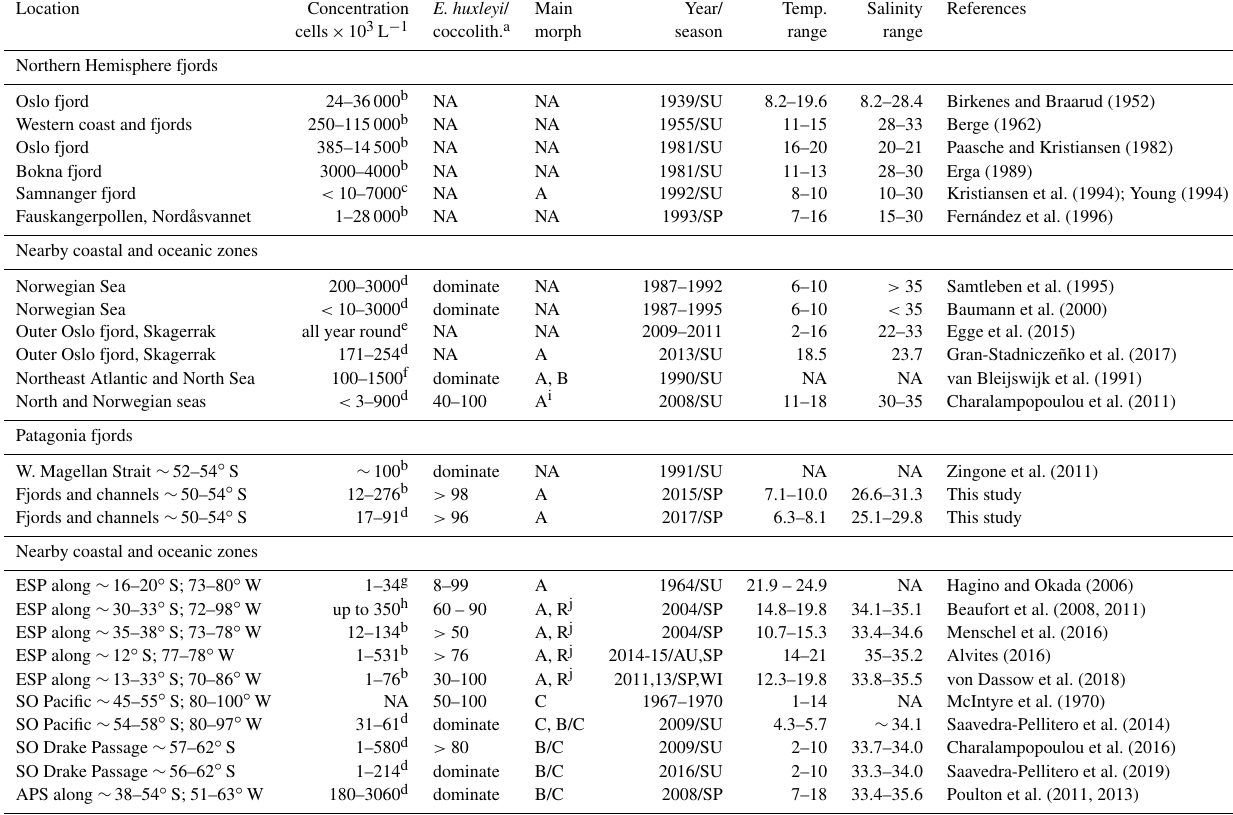
Table 4. Comparison of E. huxleyi standing stocks and morphotypes recorded in northern and Patagonia fjord systems and nearby coastal/ocean locations. Temperature and salinity ranges are shown. Only data < 10m in depth were included. ESP: eastern South Pacific; SO: Southern Ocean; APS: Atlantic Patagonian Shelf; SU: summer; SP: spring; WI: winter; AU: autumn; NA: no available